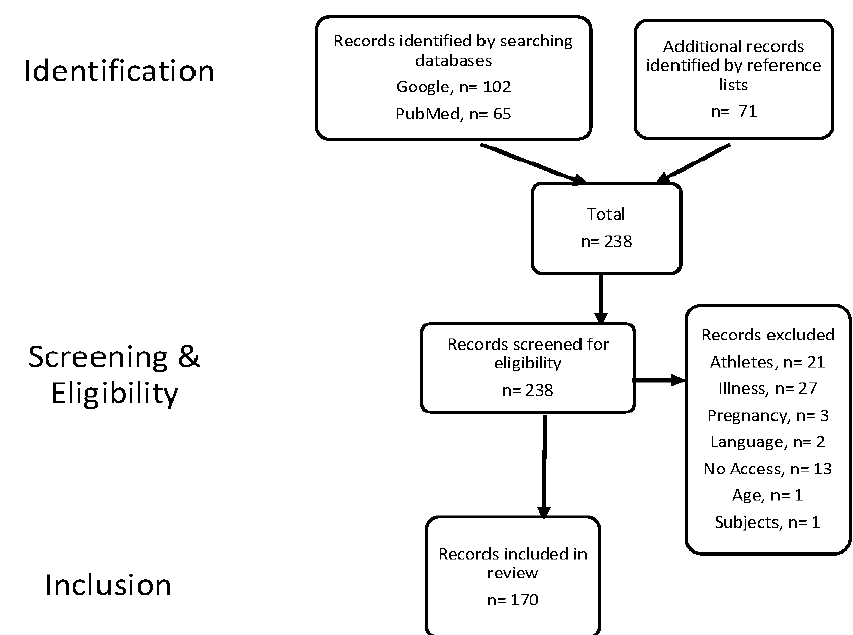
Figure 1. Flow diagram showing study selection based on inclusion and exclusion criteria.